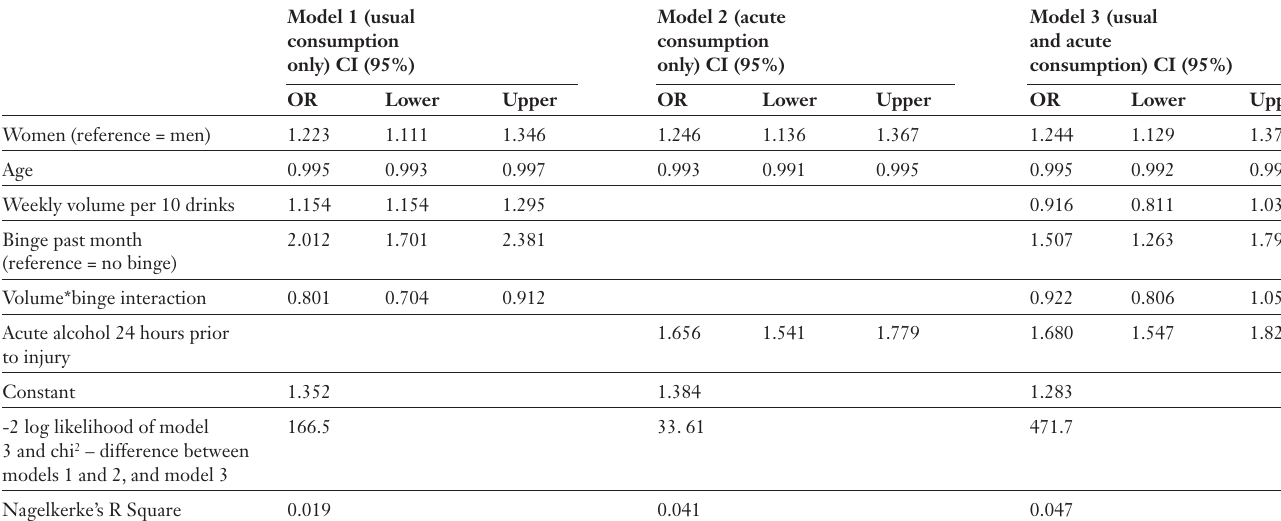
Logistic regressions of current injury status on usual and acute alcohol